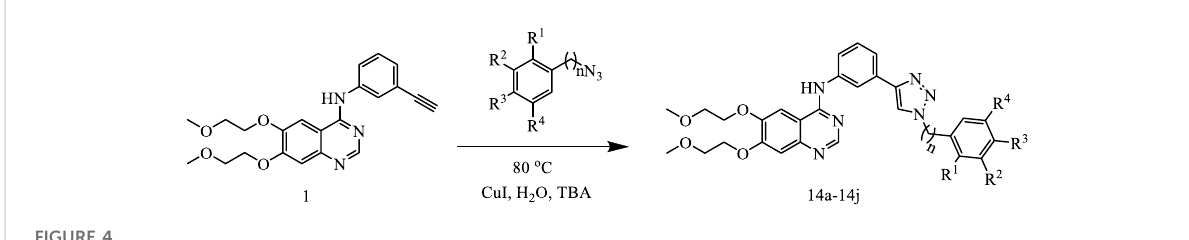
FIGURE 4 The reaction routes to erlotinib-1,2,3-triazole derivatives.